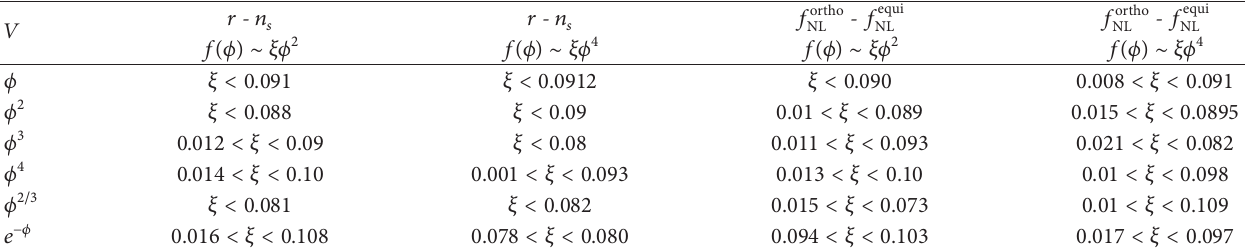
Table 1: The ranges of 𝜉 in which the values of the inflationary parameters 𝑟 and 𝑛 𝑠 and also 𝑓 ortho NL and 𝑓 equi NL , with 𝑛 = 1 , are compatible with the 95 % CL of the Planck 2015